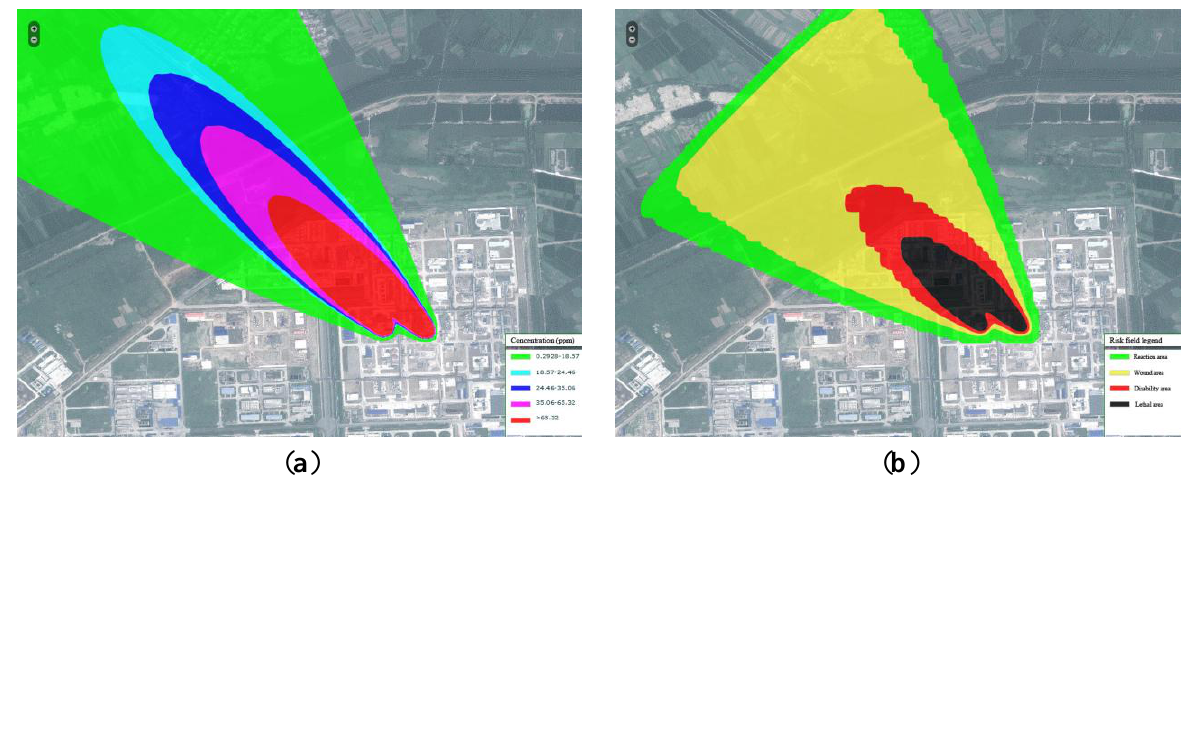
Figure 5. Gas-gas H S leakage. Image ( a ) shows the concentration field and image, 2 ( b ) shows the risk